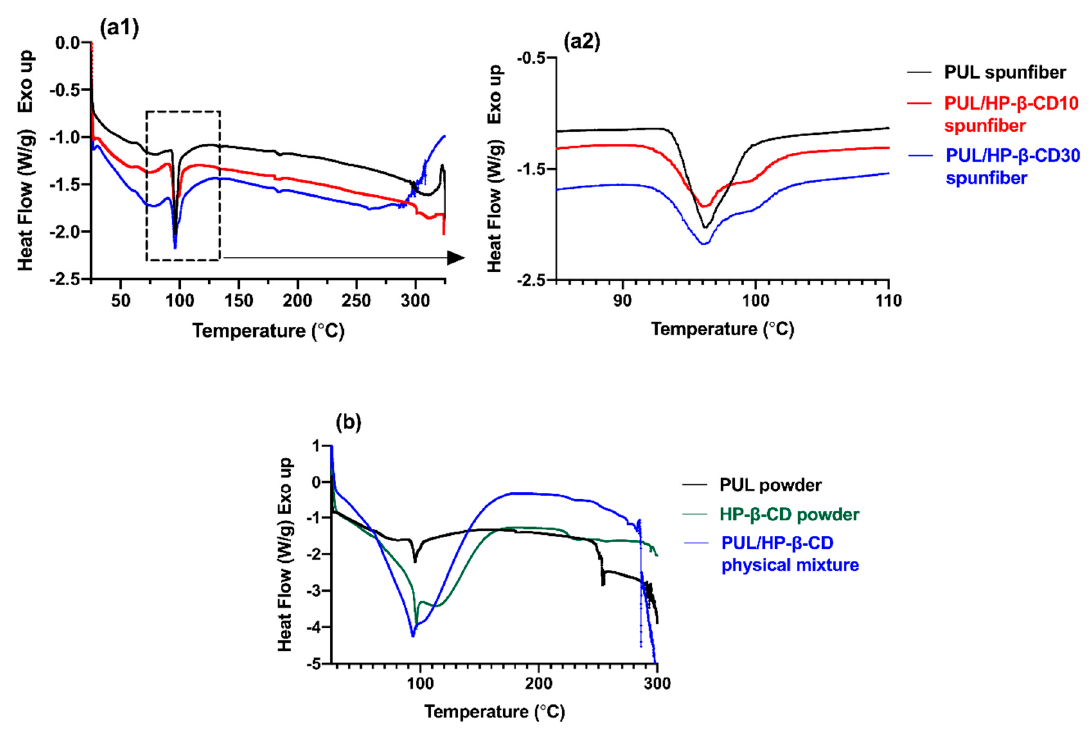
Figure 8. ( a1 ) Differential Scanning Calorimetry (DSC) thermograms and ( a2 ) enlarged region of thermograms between 85 and 110 ◦ C of pullulan electrospun nanofibers containing 0% (black), 10% (red) and 30% (blue) of HP- β -CD. Polymer solution concentration 20% (w/v). ( b ) DSC thermograms of pure ground components (pullulan, HP- β -CD) and pullulan/HP- β -CD physical mixture.